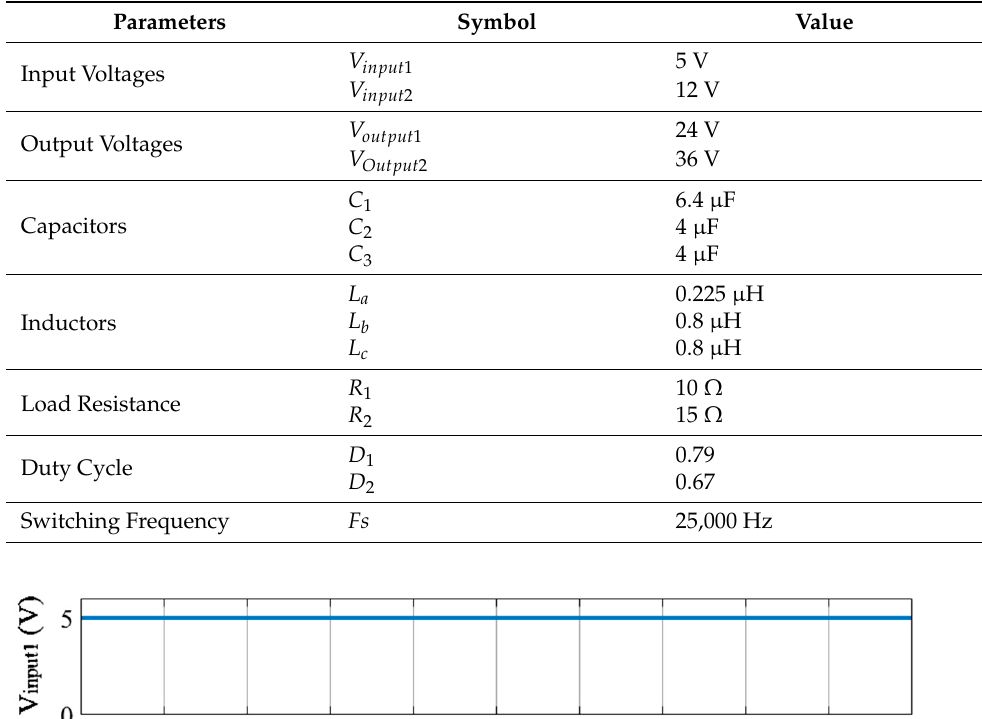
Table 1. Design parameters.